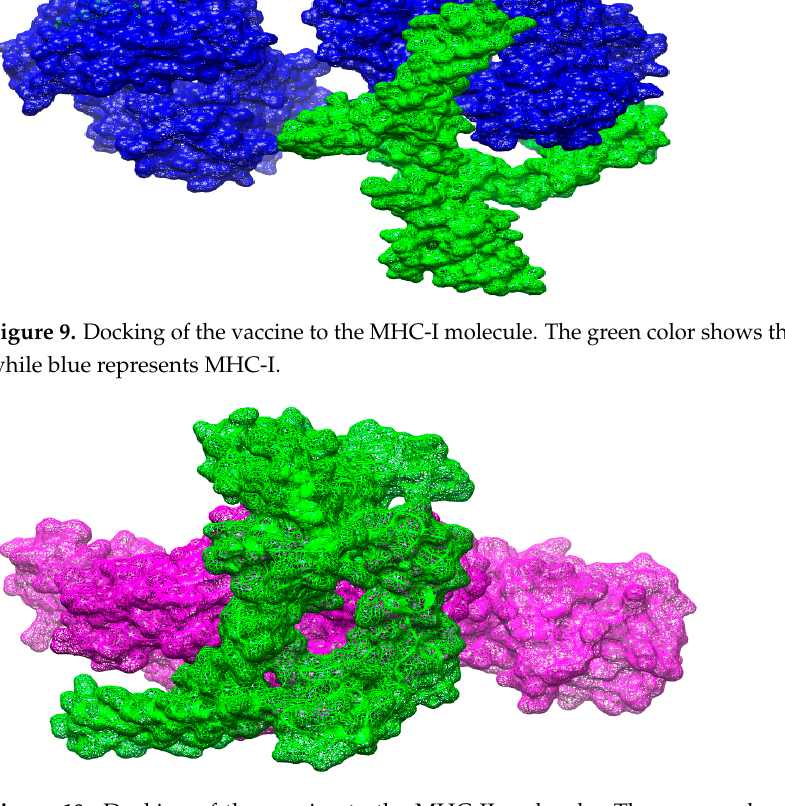
Figure 11. Docking of the vaccine to the TLR ‐ 4 molecule . The green color shows the vaccine mole ‐ cule while purple represents TLR ‐ 4.